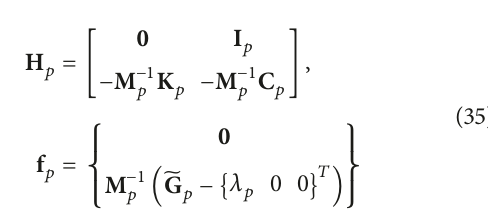
Figure 7: Periodicity of the catenary: (a) an infinite long catenary and (b) the interaction forces for unit cells of the catenary.